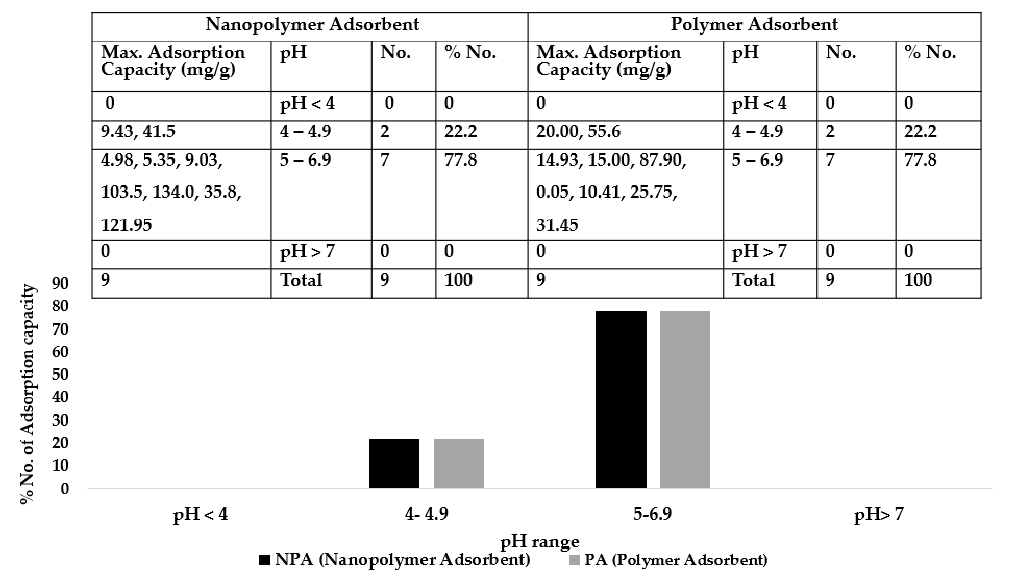
Figure 8. pH at maximum adsorption capacities for polymer and nanopolymer adsorbent.